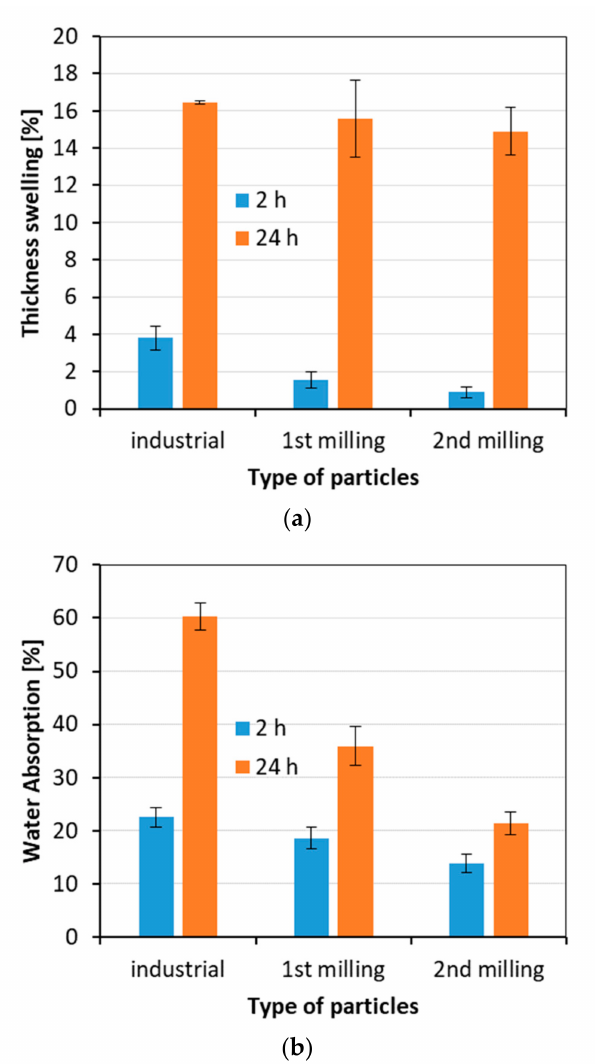
Figure 7. The thickness swelling ( a ) and water absorption ( b ) of the panels produced using different